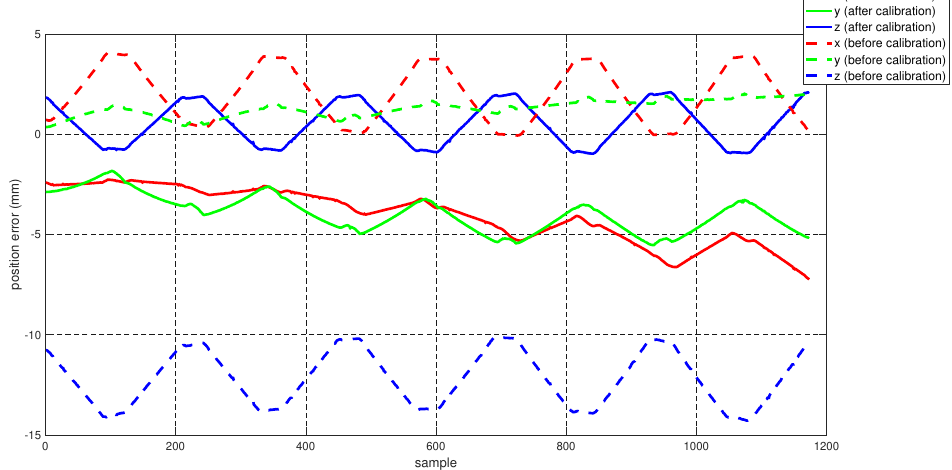
Figure 9. Test set position error along individual